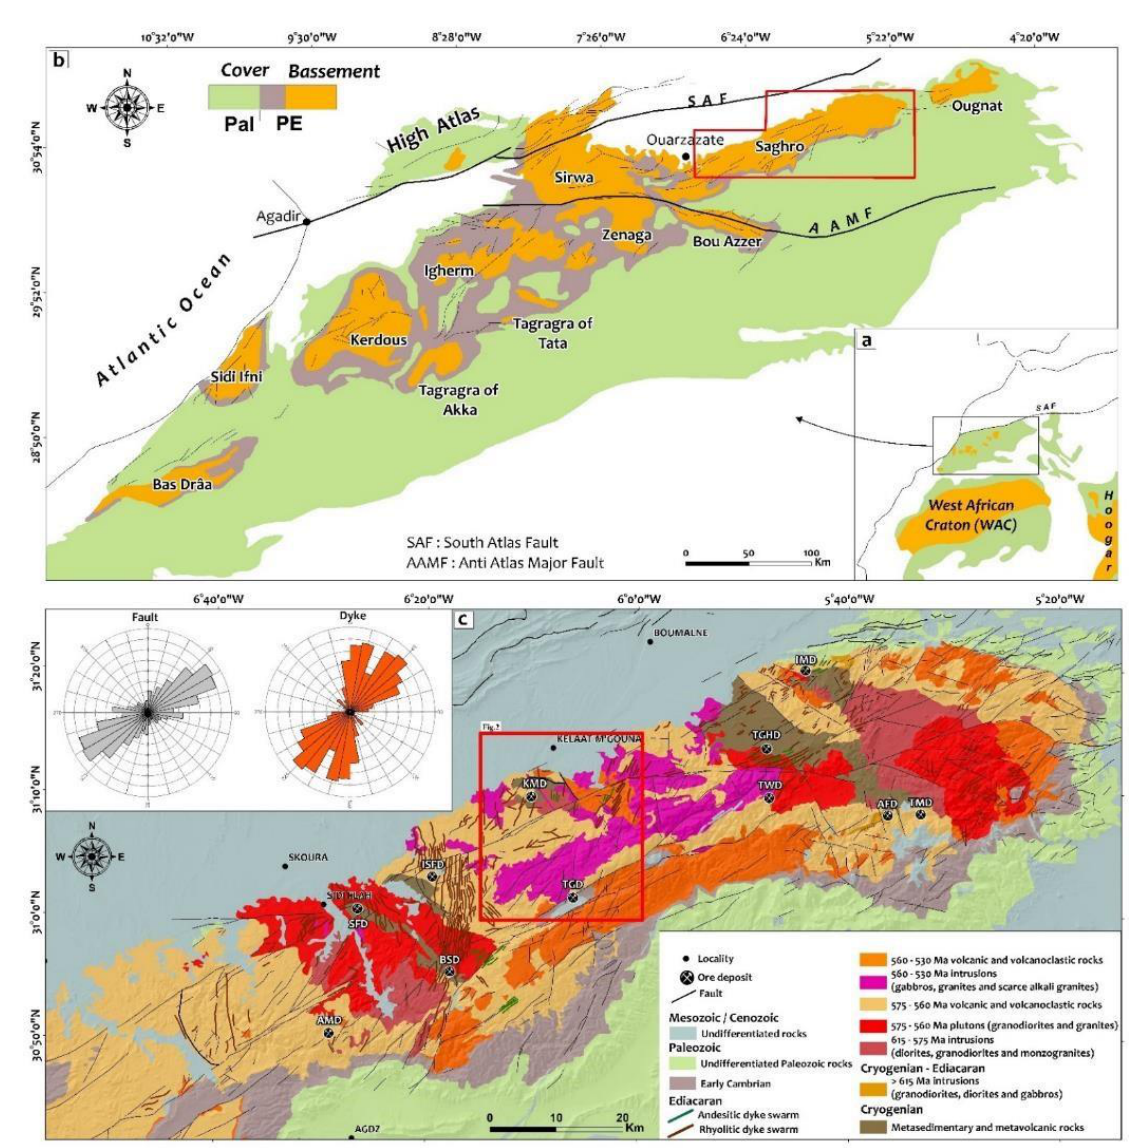
Figure 1. ( a ) Location of the Moroccan Anti-Atlas Range relative to the West African Craton [33]. ( b ) General geological map of the Anti-Atlas showing its main Precambrian inliers [34,35], modified. ( c ) Geological map of the Saghro Massif with its main metalliferous deposits (IMD: Imeter Deposit; TGHD: Taghassa Deposit; KMD: Kelâat M’Gouna Deposits; ISFD: Issarfane; BSD: Bouskour Deposit; AMD: Amzwaro Deposit; TMD: Tizi Moudou Deposit; AFD: Asfalou Deposit; TWD: Tiwit Deposit; TGMD: Tagmout Deposit; SFD: Sidi Flah Deposit). In addition, their rose diagrams showing the trends of faults on the left and dykes on the right. The study area is marked by the red polygon [36,37], modified.